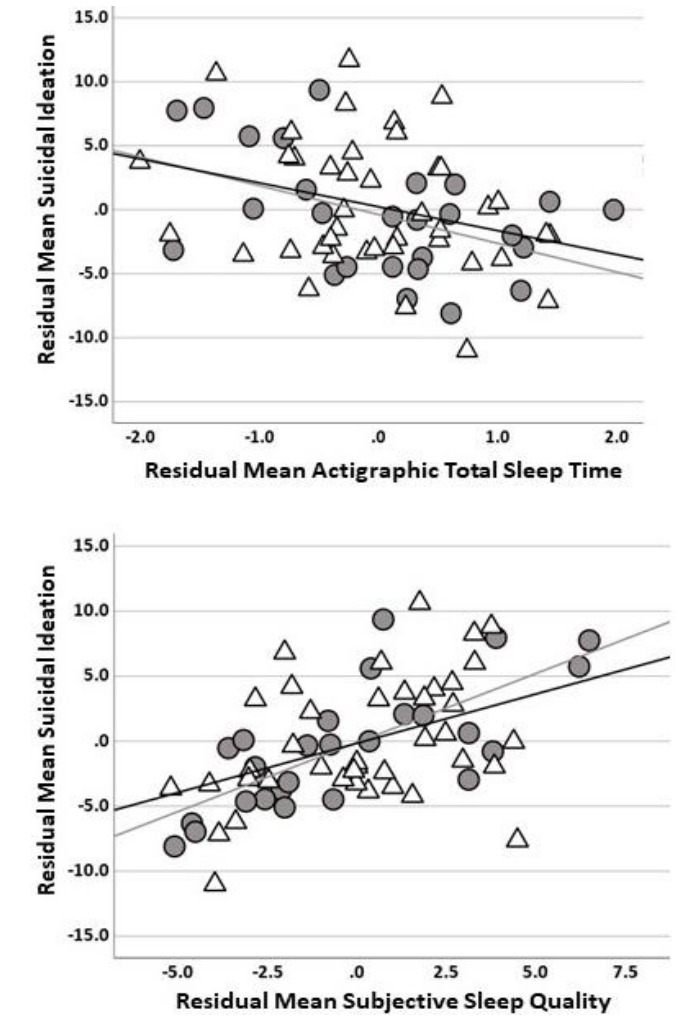
Figure 1. Scatterplot illustrating relationship between actigraphic total sleep time and suicidal ideation controlling for depression (HAMD), anxiety (LSAS), and age in years (i.e., residuals) (top panel); Scatterplot depicting relationship between sleep quality (PSQI) and suicidal ideation controlling for depression (HAMD), anxiety (LSAS), and age in years (i.e., residuals) (bottom panel). Note: Suicidal ideation = Inventory of Depression and Anxiety Symptoms, Second Version suicidality subscale; HAMD = Hamilton Depression Rating Scale; LSAS = Liebowitz Social Anxiety Scale; PSQI = Pittsburg Sleep Quality Index; gray circles and gray fit line = major depressive disorder; black triangles and black fit line = social anxiety disorder.